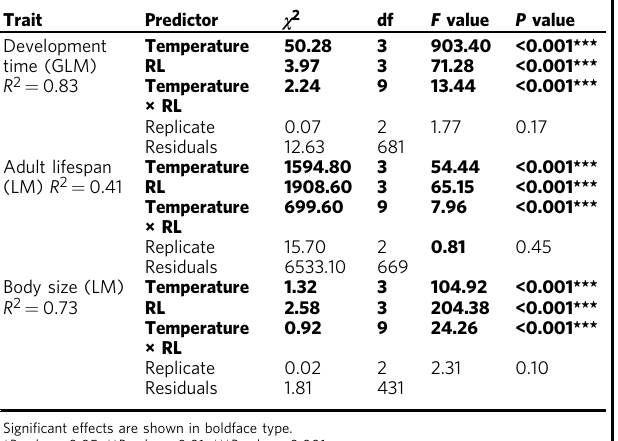
Table 1 Type II Analysis of Variance results from regression models fi tted to the responses of life history traits to temperature and resource level (RL).